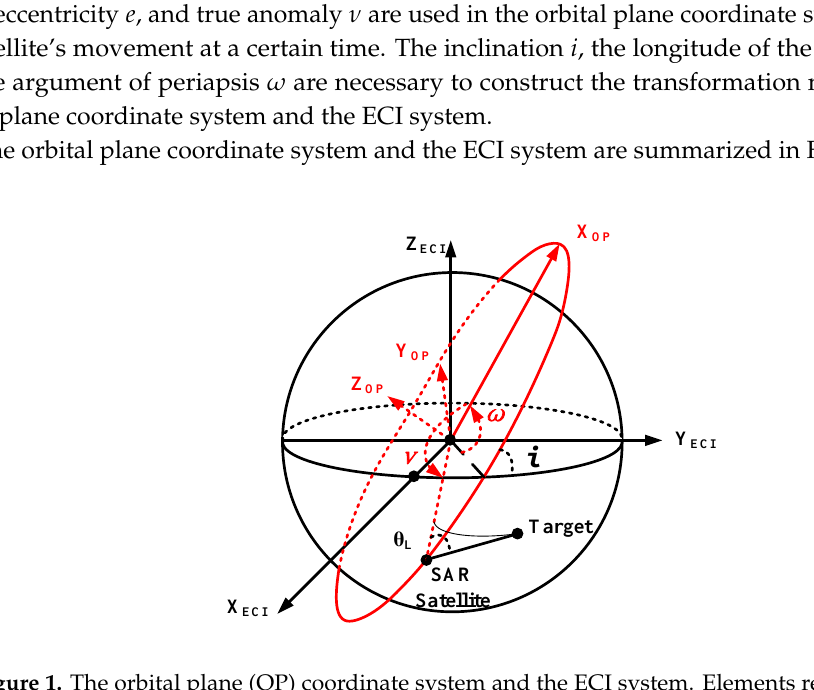
Figure 1. The orbital plane (OP) coordinate system and the ECI system. Elements related to the OP coordinate system are in red. ω is the argument of periapsis, i is the orbit eccentricity, ν is true anomaly, and θ L is the center off-nadir angle in